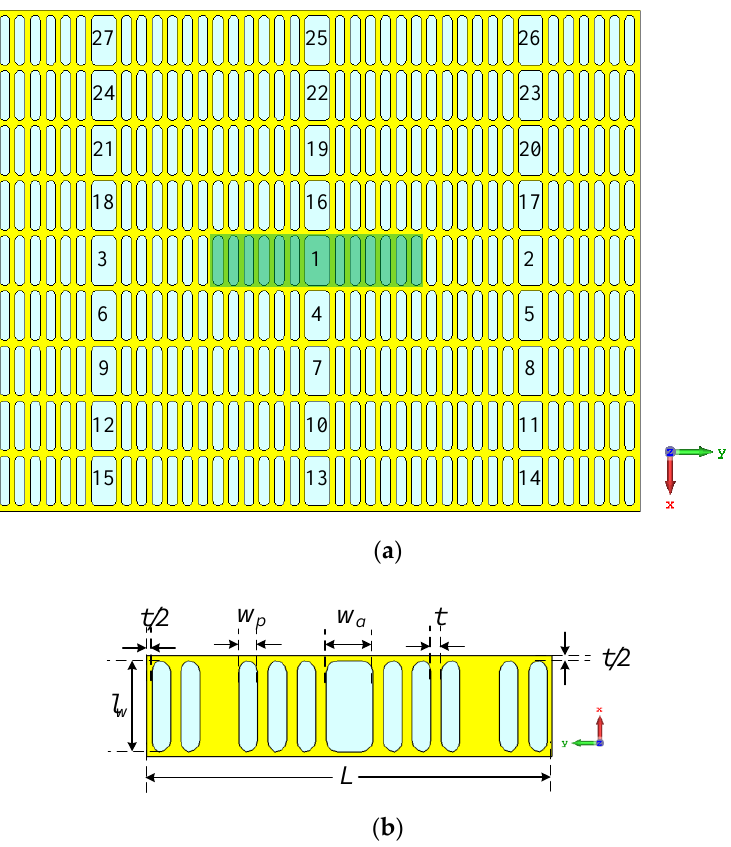
Figure 2. ( a ) Planar N A = 9 × 3 array configuration using high-gain sub-arrays of open-ended waveguides. The central sub-array is highlighted in green, whereas the relevant geometrical parameters are reported in ( b ).